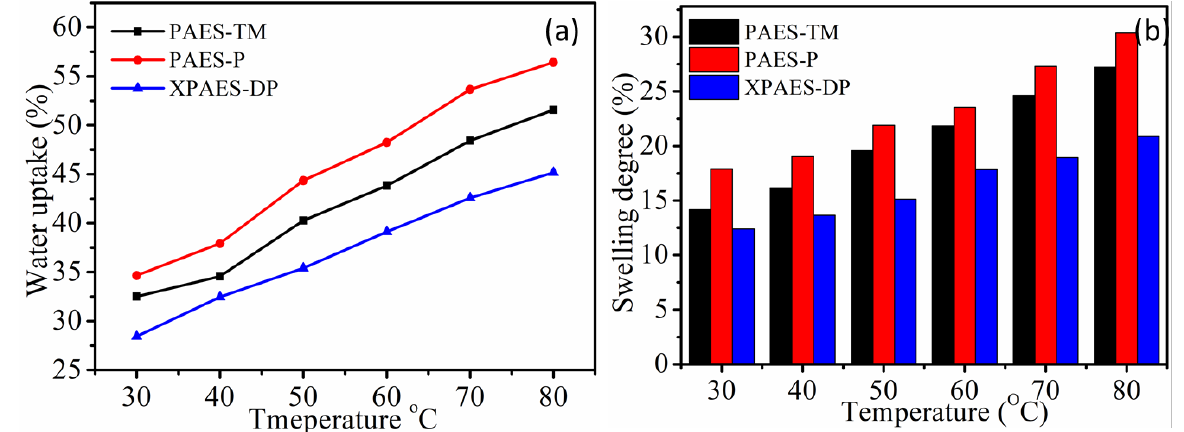
Figure 2. ( a ) Water uptake and ( b ) swelling ratio of different membranes at different temperature.